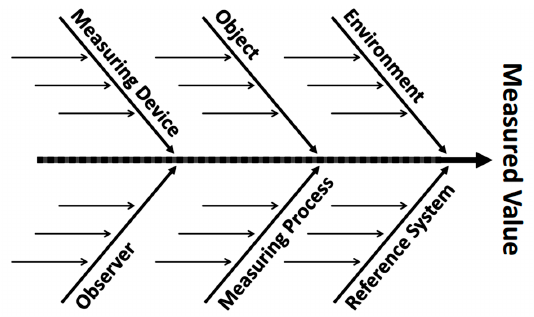
Figure 4. Ishikawa diagram to analyze all the influence factors for a GUM analysis.